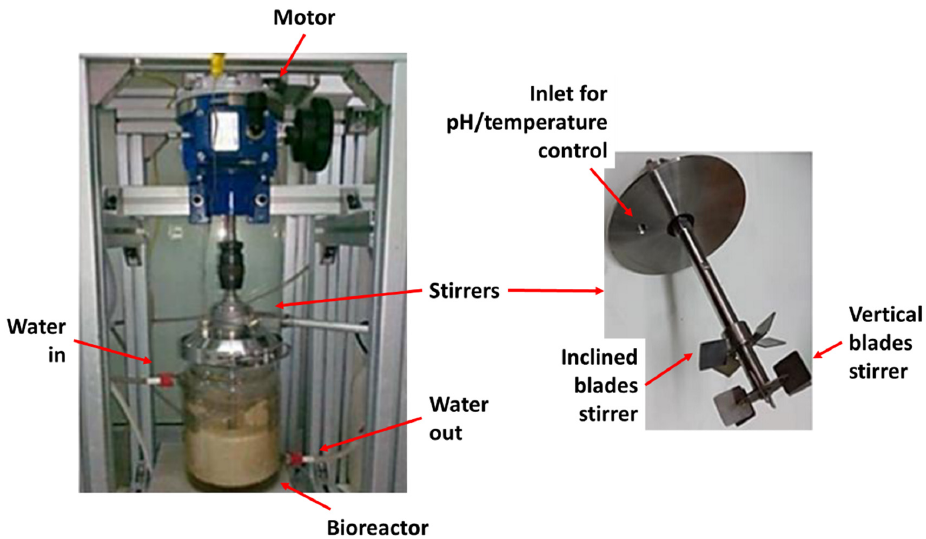
Figure 2. Experimental set-up of the fermentation system.